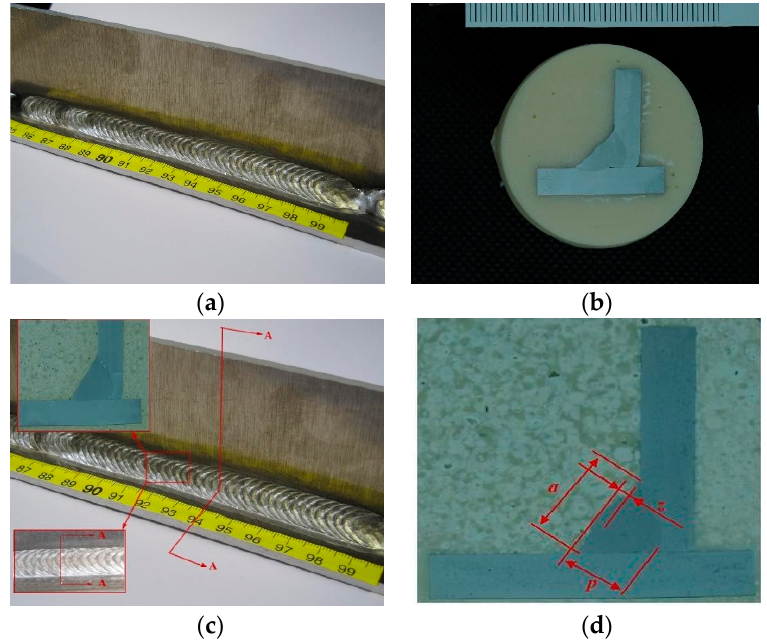
Figure 2. Sample made by welding with the synchropulse welding process: ( a ) Welded joint of the sample No. 17, ( b ) macro sample No. 17, ( c ) cross section of welded joint used for measuring the output variables, ( d ) measuring output variables on thin sections; a —weld width (mm); z —insufficient/excessive throat thickness (mm); p —penetration (mm).